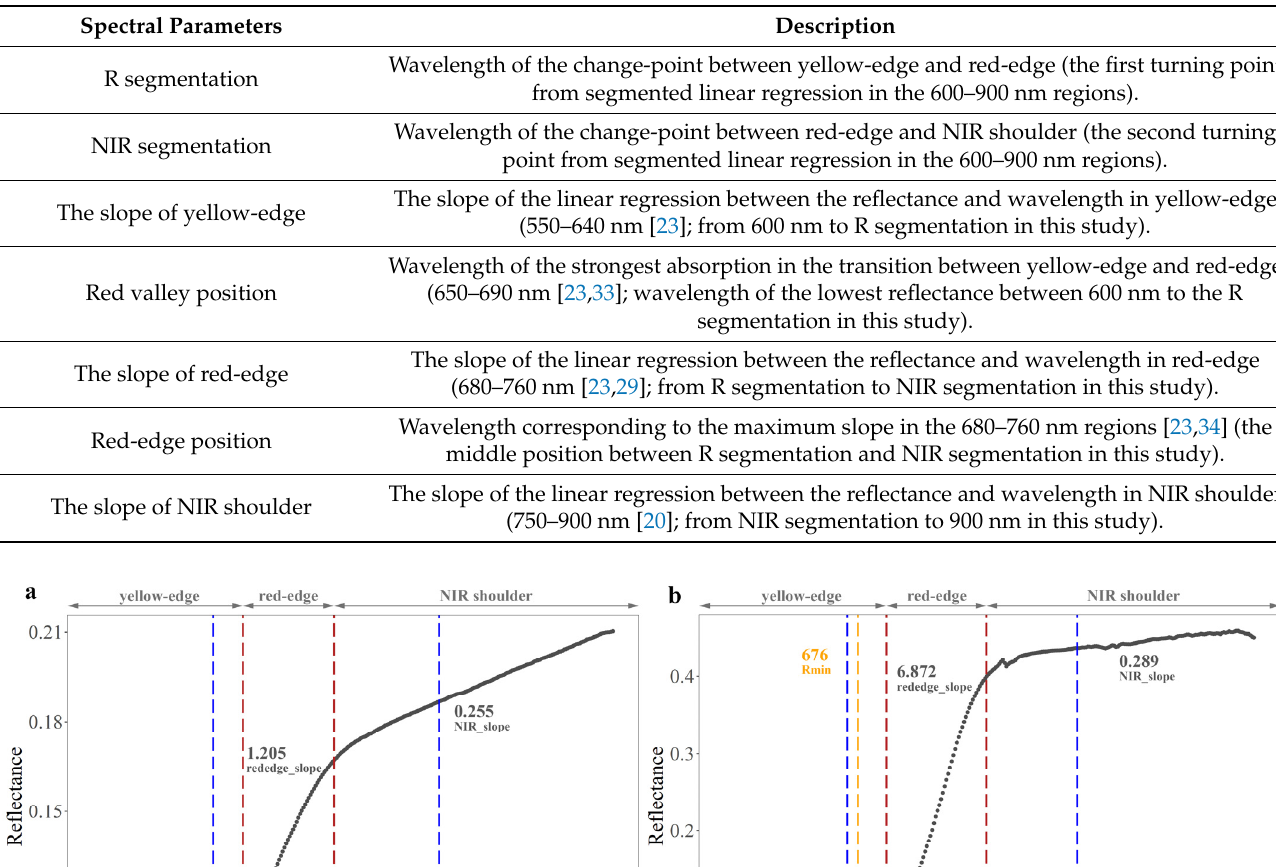
Table 2. Spectral parameters of yellow-edge, red-edge and NIR shoulder.